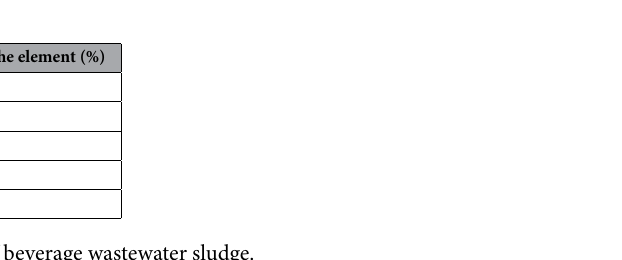
Table 1. The ultimate analysis result of beverage wastewater